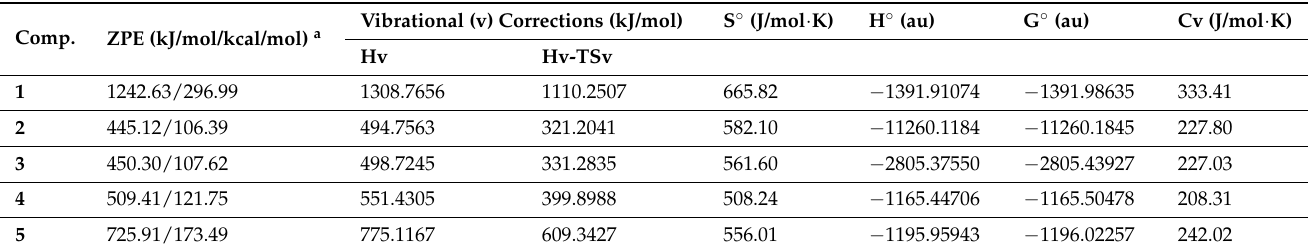
Table 9. ZPE (zero-point energy) and vibrational (v) corrections (as either Temp. Correction (Hv) or Entropy Correction (Hv-TSv)), as well as the entropy S ◦ , enthalpy H ◦ , Gibbs energy G ◦ , and heat ca- pacity at constant volume Cv for the trans conformation of complexes 1 – 5 (Standard Thermodynamic quantities at 298.15 K and 1.00 atm).